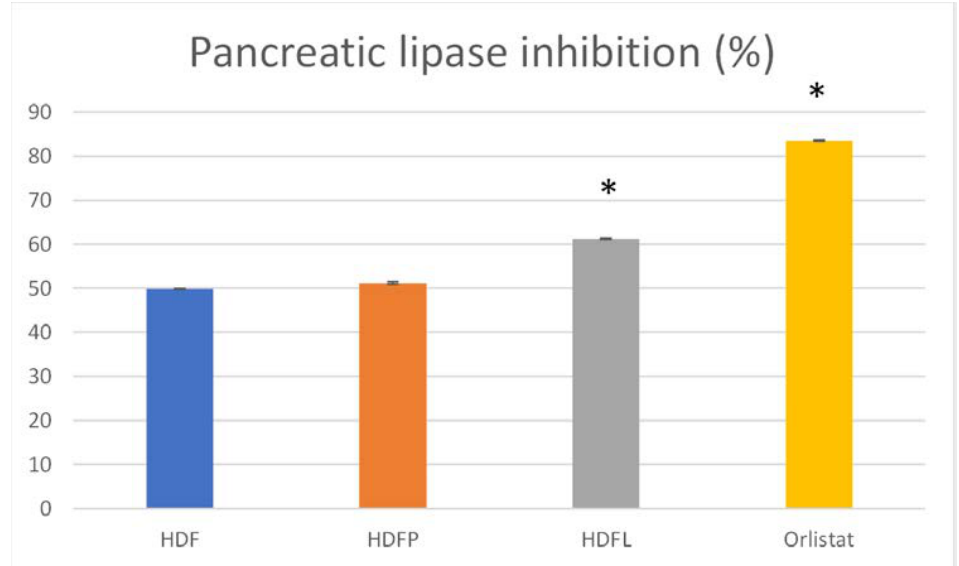
Figure 8. Pancreatic lipase inhibition. Orlistat (6 mg/mL) was used as a positive control. Fruc- tans/agave fructan bioconjugates were evaluated at 1 mg/mL. Asterisks denote a significant dif- ference vs. control ( p < 0.05) after one-way ANOVA and Tukey tests. Error bars are ± standard deviation. Treatment acronyms as in Figure 4. * p <